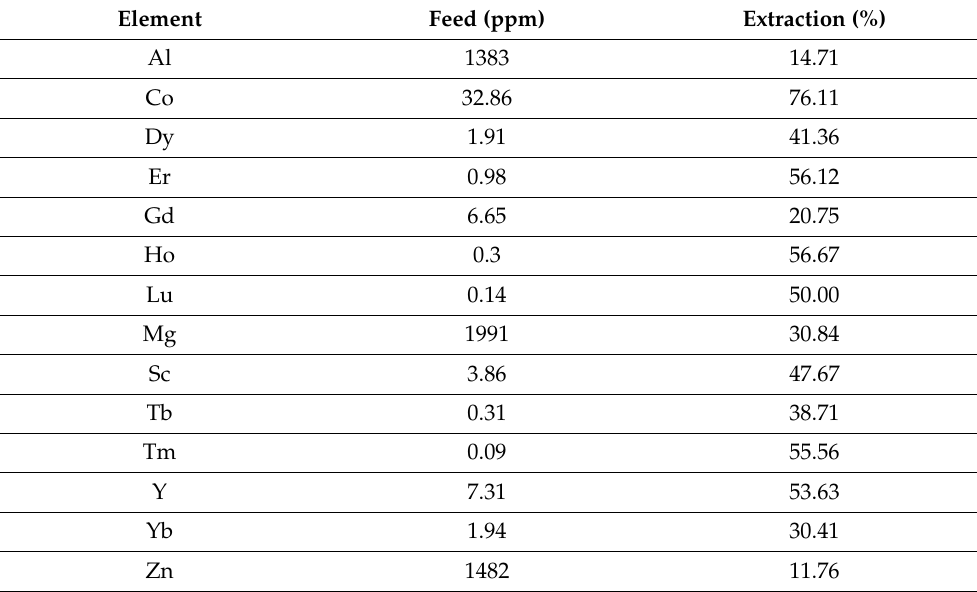
Table 1. Pyrite concentrate feed material REE/CM content for selected elements for which the extraction exceeds 10% during biooxidation. Element Feed (ppm) Extraction